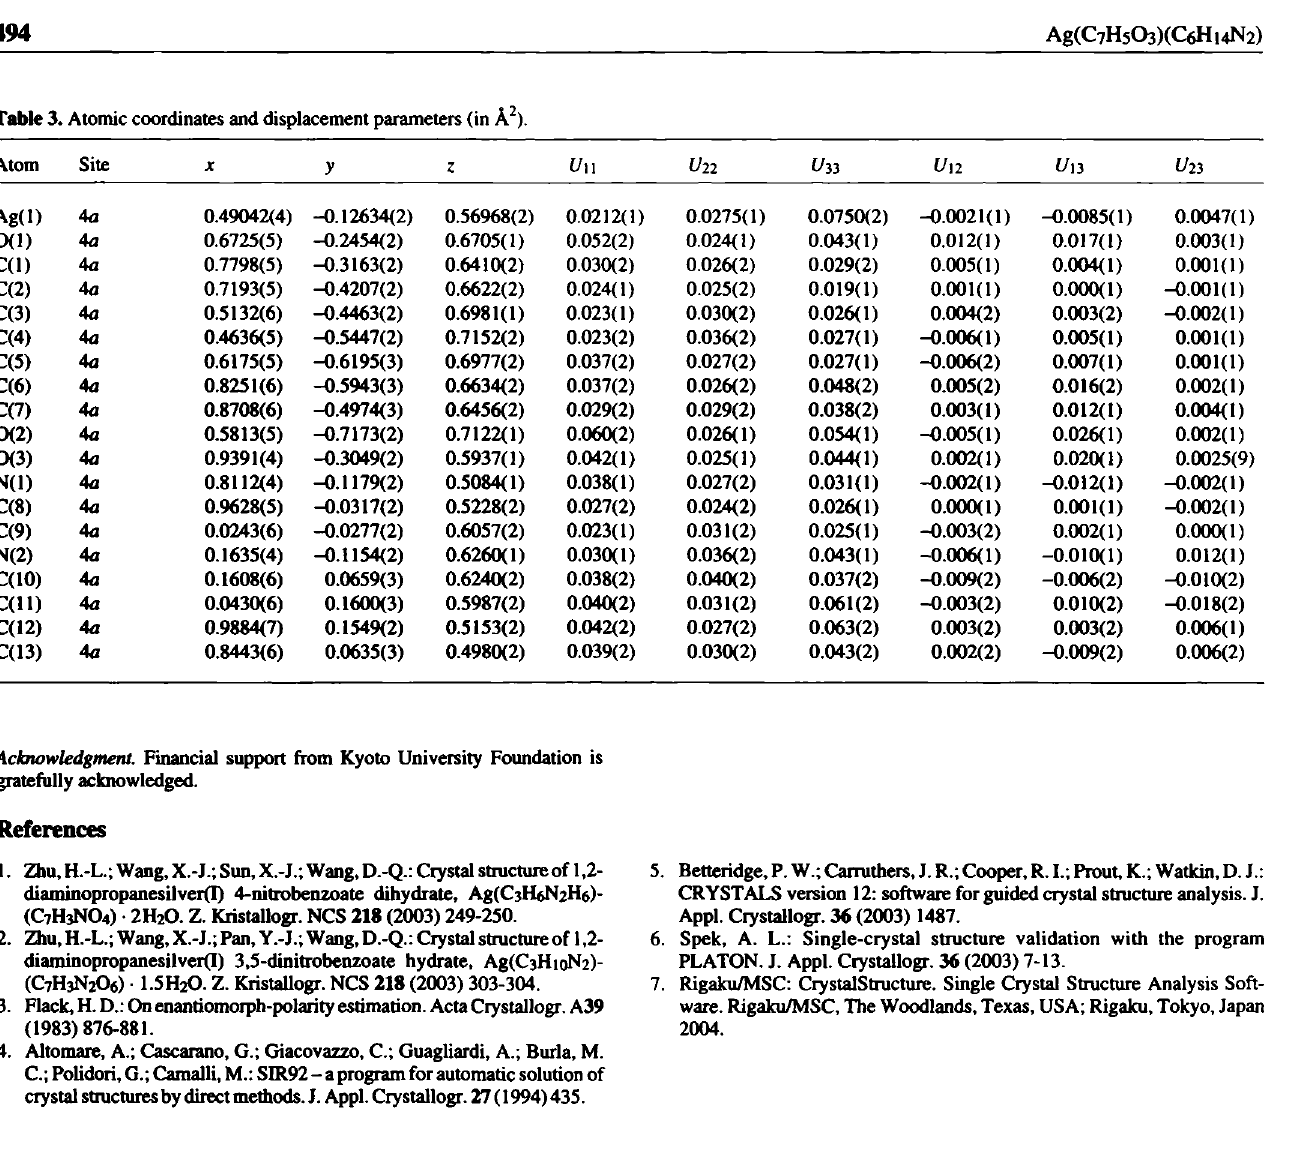
Table 3. Atomic coordinates and displacement parameters (in A 2